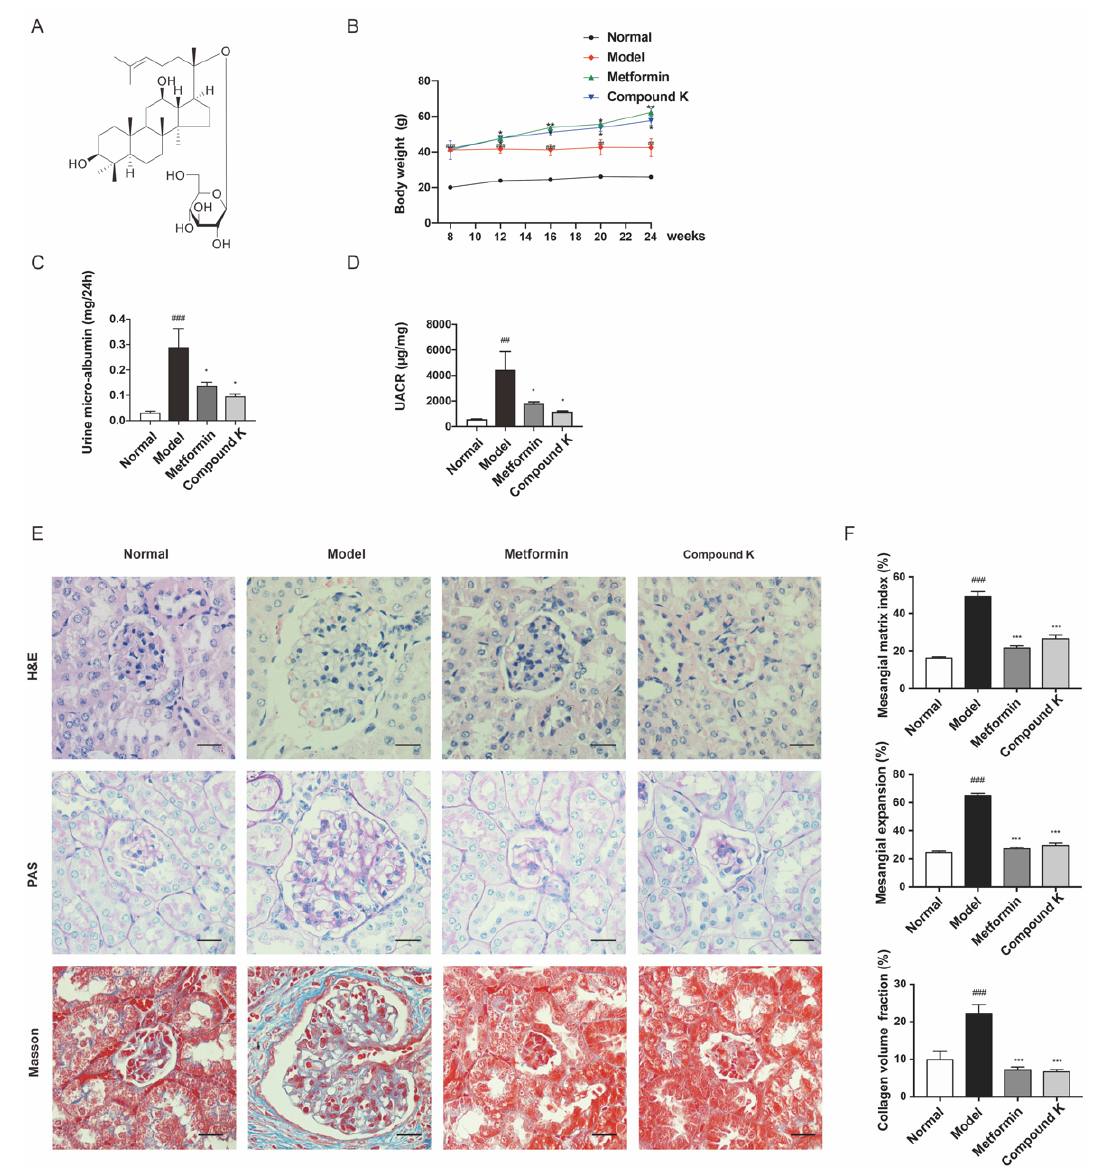
Figure 1. CK supplementation protects against diabetic kidney injury in db/db mice. ( A ) Chemical molecular structure of CK. ( B ) Body weight of experimental mice. ( C , D ) Levels of urine microalbumin and UACR. ( E ) HE staining was used for analysis of histological abnormalities, PAS staining was used for the detection of glycogen (purple), and Masson staining was used for the detection of type IV collagen (blue) in kidney section. Scale bar, 20 µ m. ( F ) Mesangial matrix index of 20 randomly selected glomeruli per mouse in each group (HE); semiquantification of mesangial expansion (PAS) and collagen volume fraction (Masson) in the glomeruli of the different groups. Data were expressed as means ± SEM ( n = 7). ### p < 0.001, ## p < 0.01 compared to normal. *** p < 0.001, ** p < 0.01, * p < 0.05 compared to